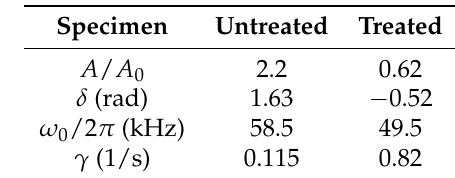
Amplitude and phase of the Doppler vibrometry signal relative to transducer and corresponding natural frequency and decay constant estimated from Equations (10) and (11).